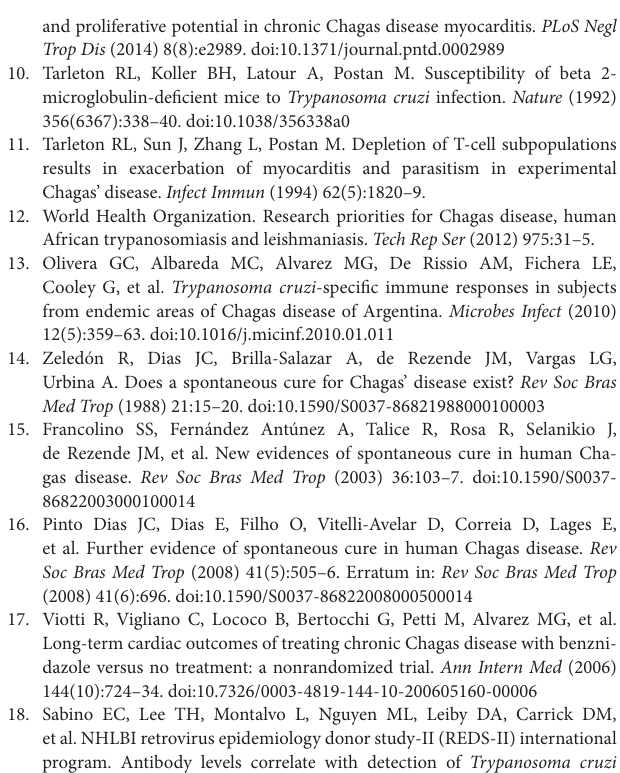
FigUre s1 | Gate strategy for the analysis of cytokine coexpression profiles of CD4 + T cells following stimulation with T. cruzi lysate. Lymphocytes were gated based on forward (FSC) and side scattering (SSC), CD3 + population was then selected and CD4 + T-cells were analyzed for TNF- α , IL-2, MIP-1 β , IFN- γ and CD154 expression. Cytokine coexpression profiles were determined using the Boolean gating function of Flow Jo